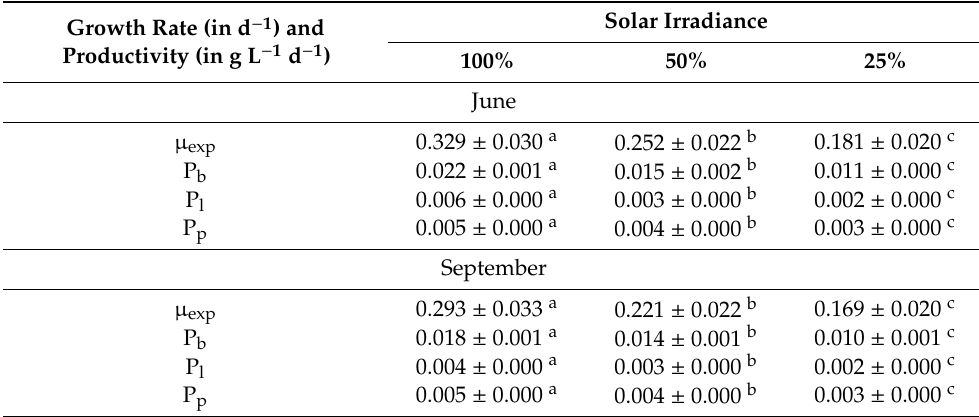
Table 1. Specific growth rates ( µ exp ) in the exponential growth phase (in d − 1 ) and biomass (P b ), lipid (P l ), and protein (P p ) productivities (in g L − 1 d − 1 ) of C. vulgaris cultivated during June and September in the greenhouse at 100%, 50% and 25% of solar irradiance.